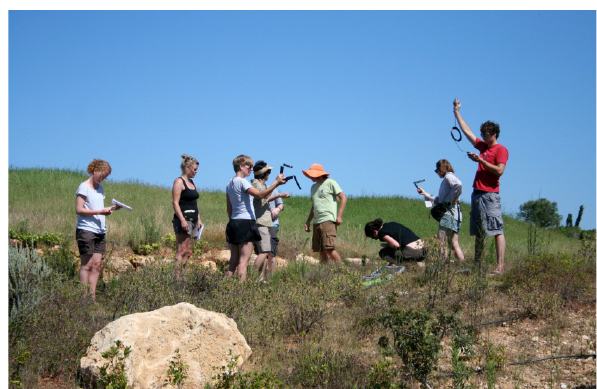
Fig. 1. Students in the field conducting measurements as part of their self-designed experiment in the course Ecohydrology: A Mediterranean perspective . M. Todd Walter (center with hat) su-